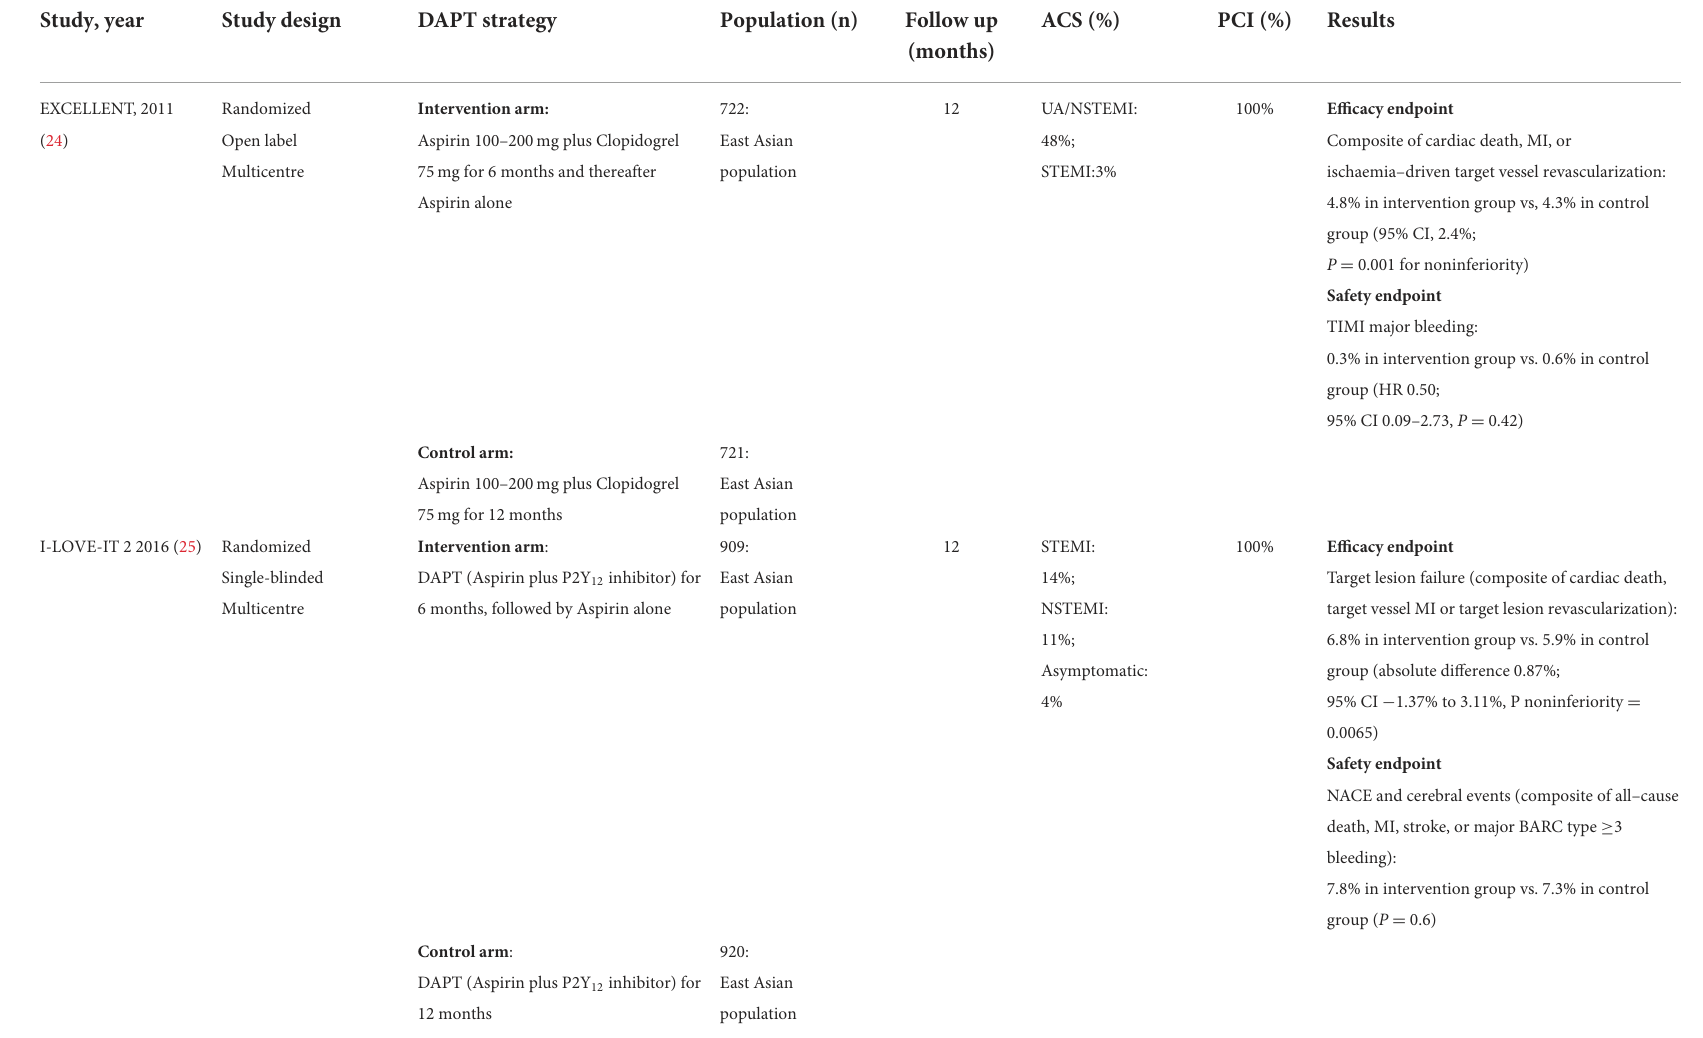
TABLE 2 De-escalation of dual antiplatelet therapy duration in ACS population undergoing PCI. Study,